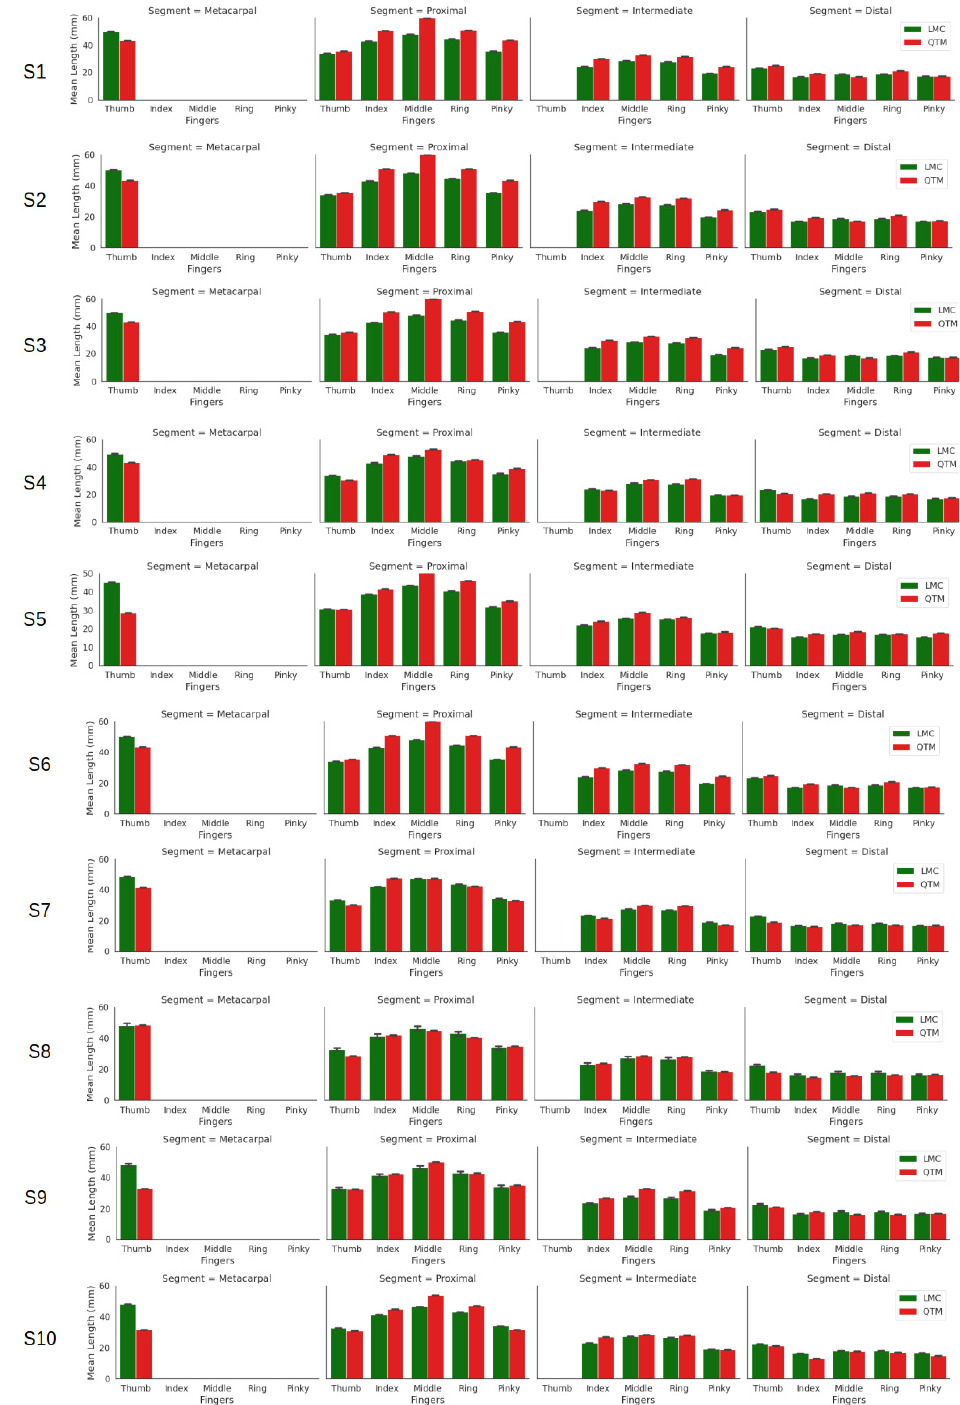
Figure 3. Segment lengths of the fingers of all ten